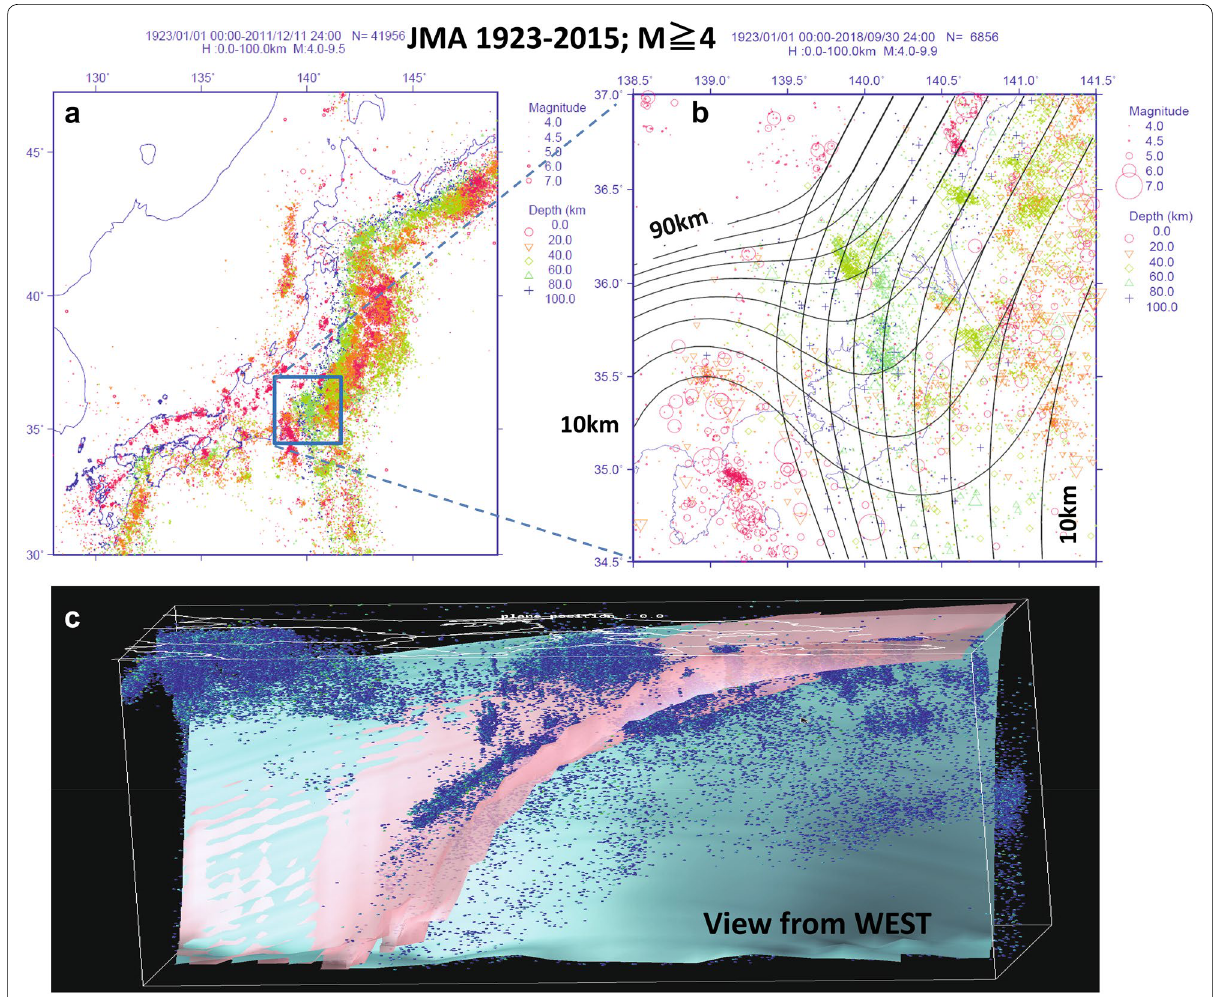
Fig. 1 Hypocenter data and plate configurations. a , b M 4.0 earthquake epicenters 1923–2015; the small circle colors change with every 20-km ≥ depth down to 100 km, and contours in b show every 10-km depth of the upper surfaces of the PHS and PAC Plates. c Perspective view from the west of the PAC (light blue) and PHS (pink) upper surfaces; dark blue dots are earthquakes of M2 and larger 2000–2018. The depth scale is